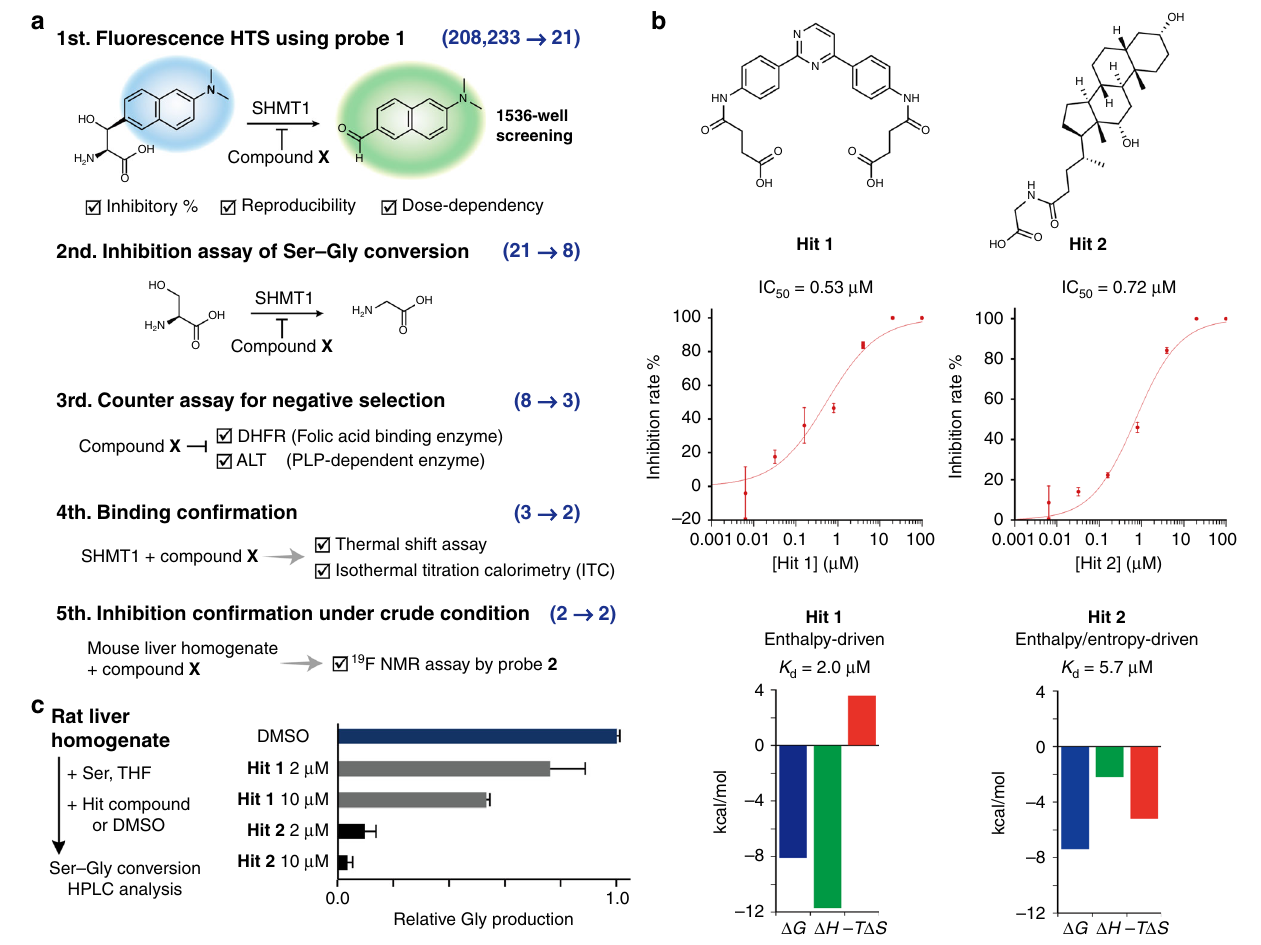
Fig. 6 hSHMT inhibitor screening by utilizing probe 1 . a Schematic illustration for hSHMT1 inhibitor screening. Details are described in the Supplementary Methods for high-throughput screening. b Chemical structures and inhibition properties of hit compounds. The IC 50 values for Hits 1 and 2 against hSHMT1 were determined by HPLC analysis of Ser – Gly conversion in the presence of various concentrations of Hits 1 and 2. Error bars represent s.d., n = 3. Thermodynamic parameters of the interactions between hSHMT1 and Hit 1 or Hit 2 were determined by ITC. c Inhibition of Ser – Gly conversion catalyzed by endogenous SHMT by Hits 1 and 2 in rat liver homogenate (250 µ g proteins/mL). Ser – Gly conversion by SHMT1 or SHMT2 in the presence of varying concentrations of Hits 1 and 2 was quanti fi ed by HPLC analysis. Error bars represent s.d., n = 3. Source data of Fig. 6b, c are provided as a Source Data fi